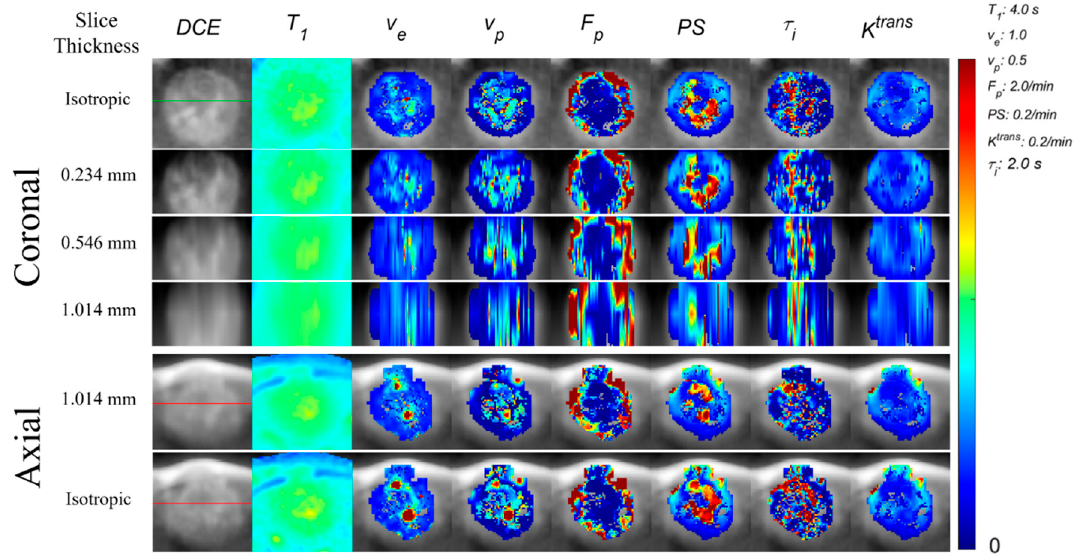
Figure 4. Impact of up-sampling anisotropic images along slice direction. The images are shown after up-sampling axial anisotropic images to isotropic resolution for the radiomics analysis. Spatial blurring of the image and parameters along the coronal direction is clearly shown. In contrast, such blurring is less remarkable in axial images (in-plane spatial resolution of 0.078 × 0.078 mm 2 ). The green line indicates the axial slice location, and the red line indicates the coronal slice location.